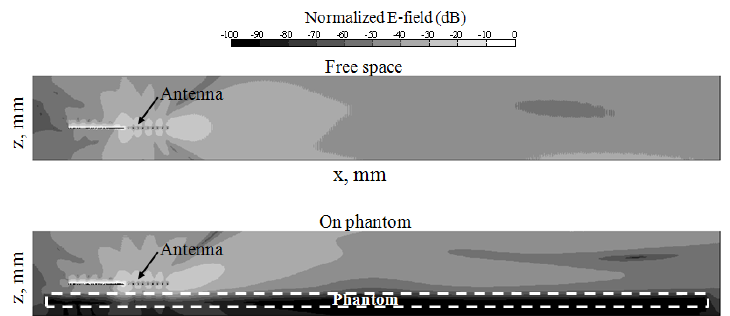
Figure 9. E -field distribution in free space and around a rectangular skin-equivalent phantom representing a human hand ( xz- plane) for antenna/phantom distance h = 5.6